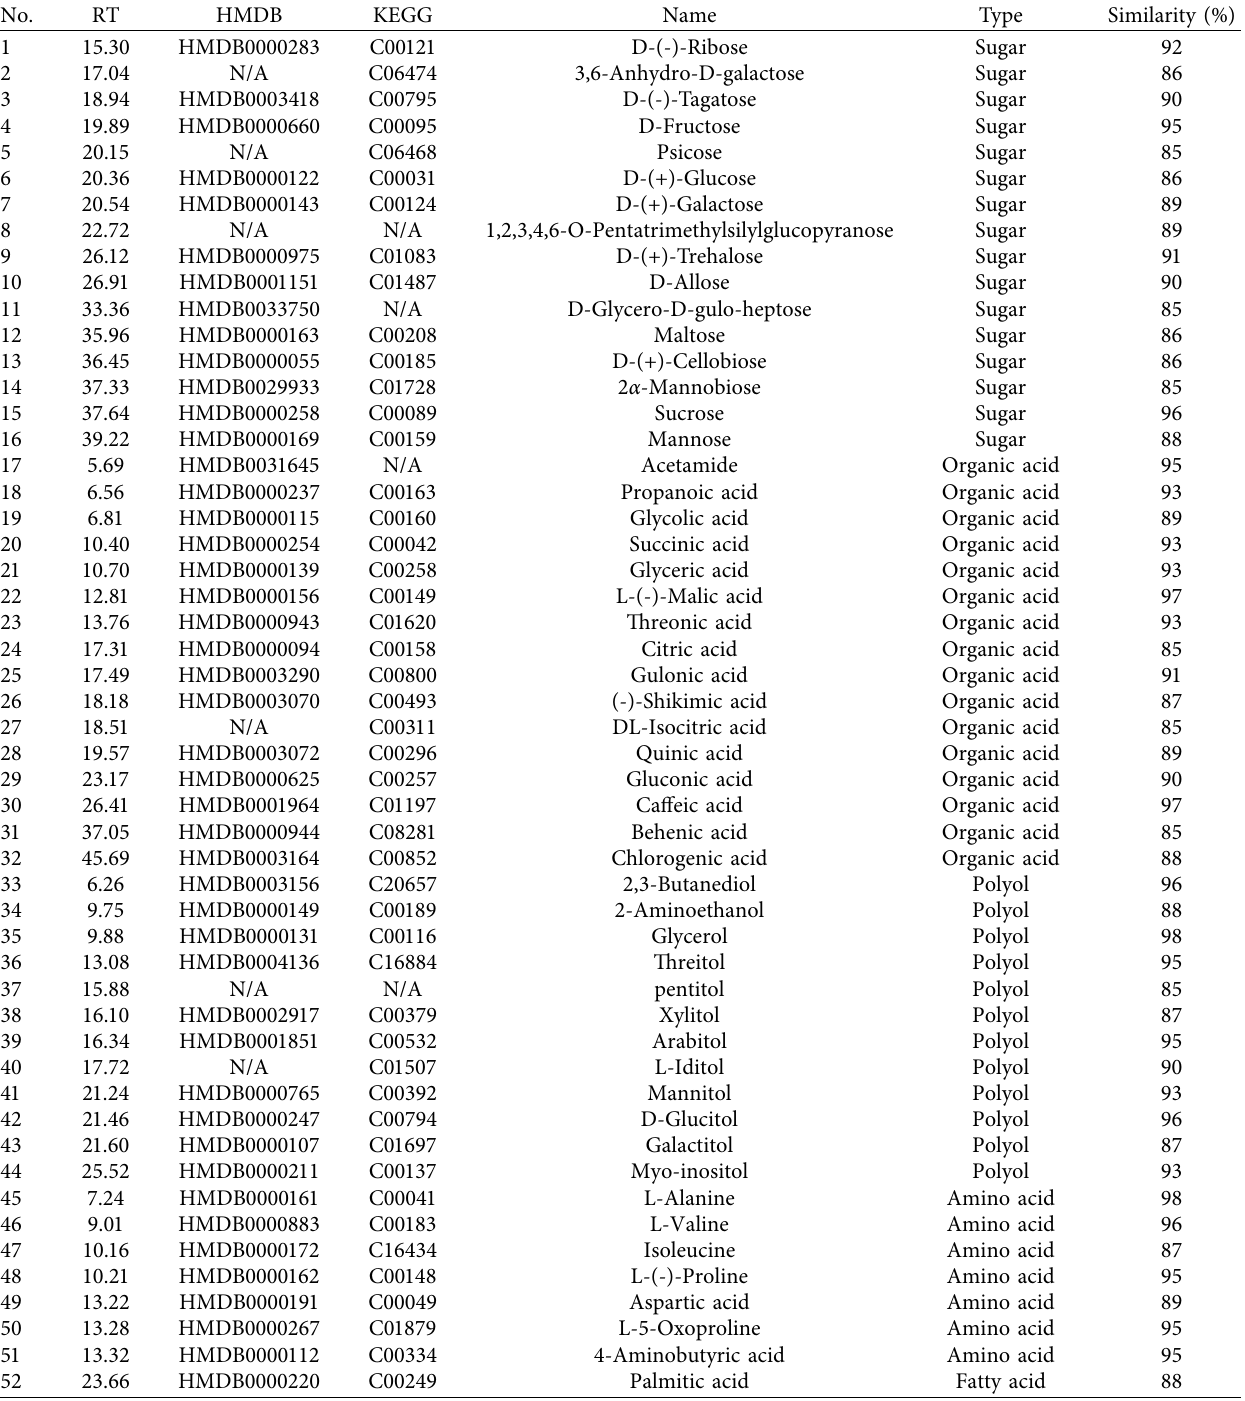
Table 1: Metabolites data based on gas chromatography-mass spectrometry